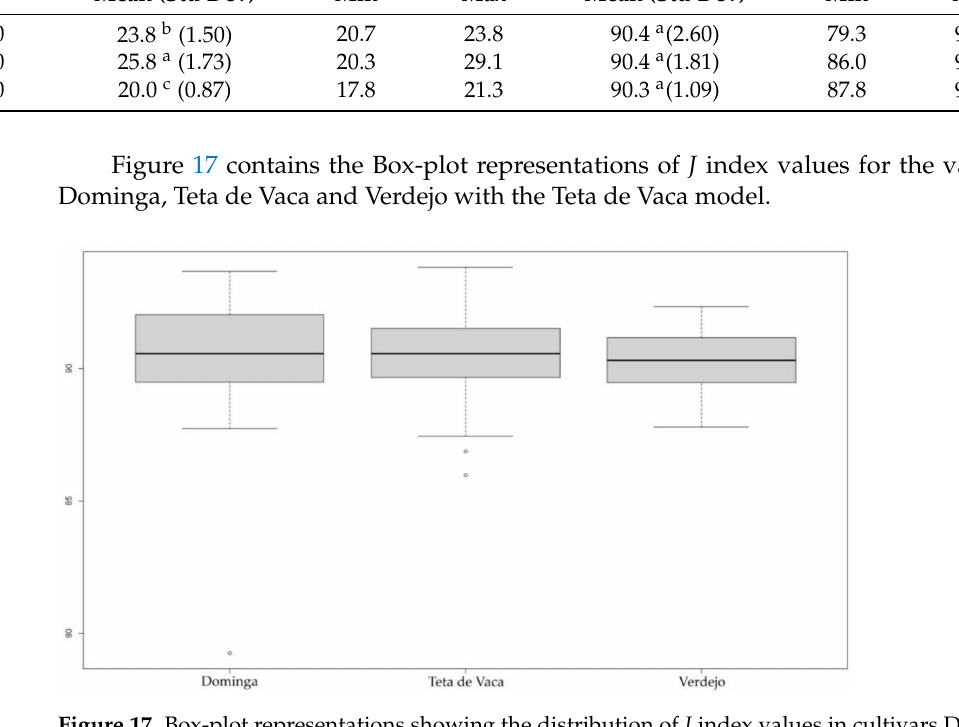
Figure 17. Box-plot representations showing the distribution of J index values in cultivars Dominga, Teta de Vaca and Verdejo with the Teta de Vaca